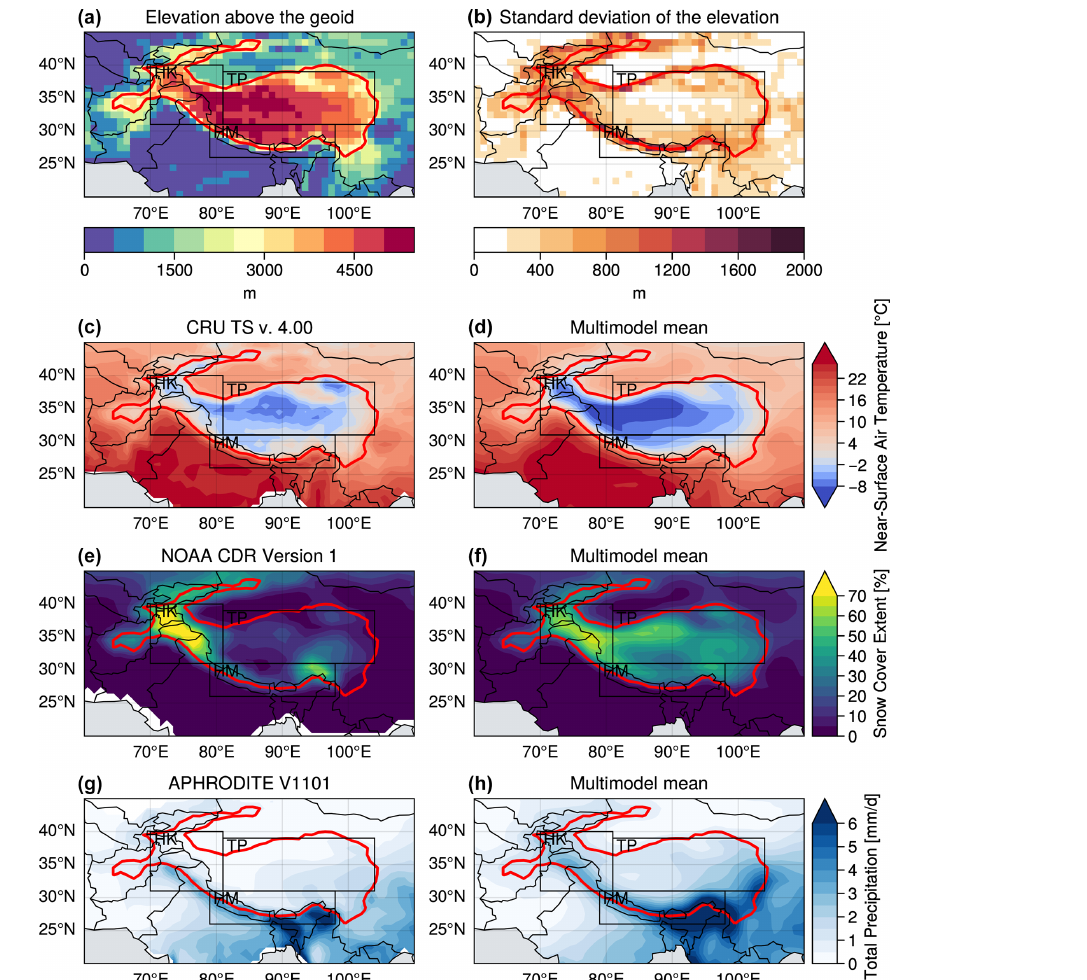
Figure 1. Surface elevation (a) and its standard deviation (b) estimated from GMTED2010 at 1 ◦ . Annual climatologies computed over 1979–2014 for temperature (c, d) , snow cover (e, f) and precipitation (g, h) ; the left panels correspond to the observations from CRU (c) , NOAA CDR (e) , and APHRODITE (g) , while the right panels (d, f, h) correspond to the multimodel mean (using the first realization of each ensemble model). The red contour highlights the HMA domain limited to areas higher than 2500ma.s.l., and the black boxes define the subdomains Hindu Kush–Karakoram (HK), Himalayas (HM), and the Tibetan Plateau (TP), which are also limited to areas higher than 2500ma.s.l. (red contour) in this